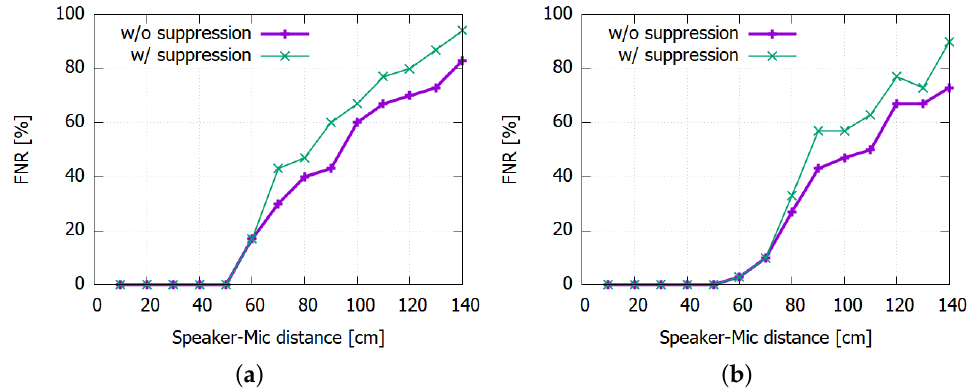
Figure 9. Detection rates at θ = 210 with and without FP suppression: ( a ) 6 s. ( b ) 10 s.